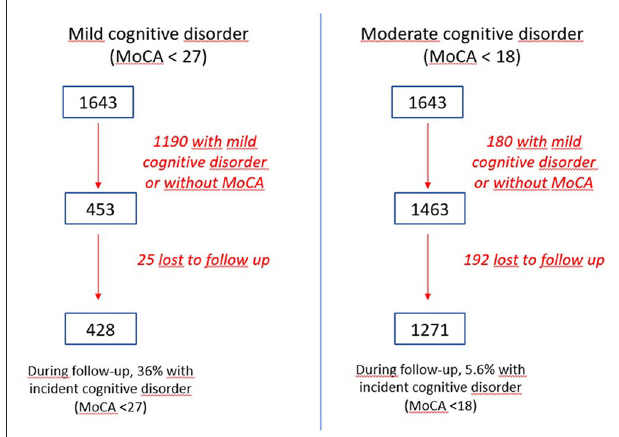
FIGURE 2 | Flow chart of the two